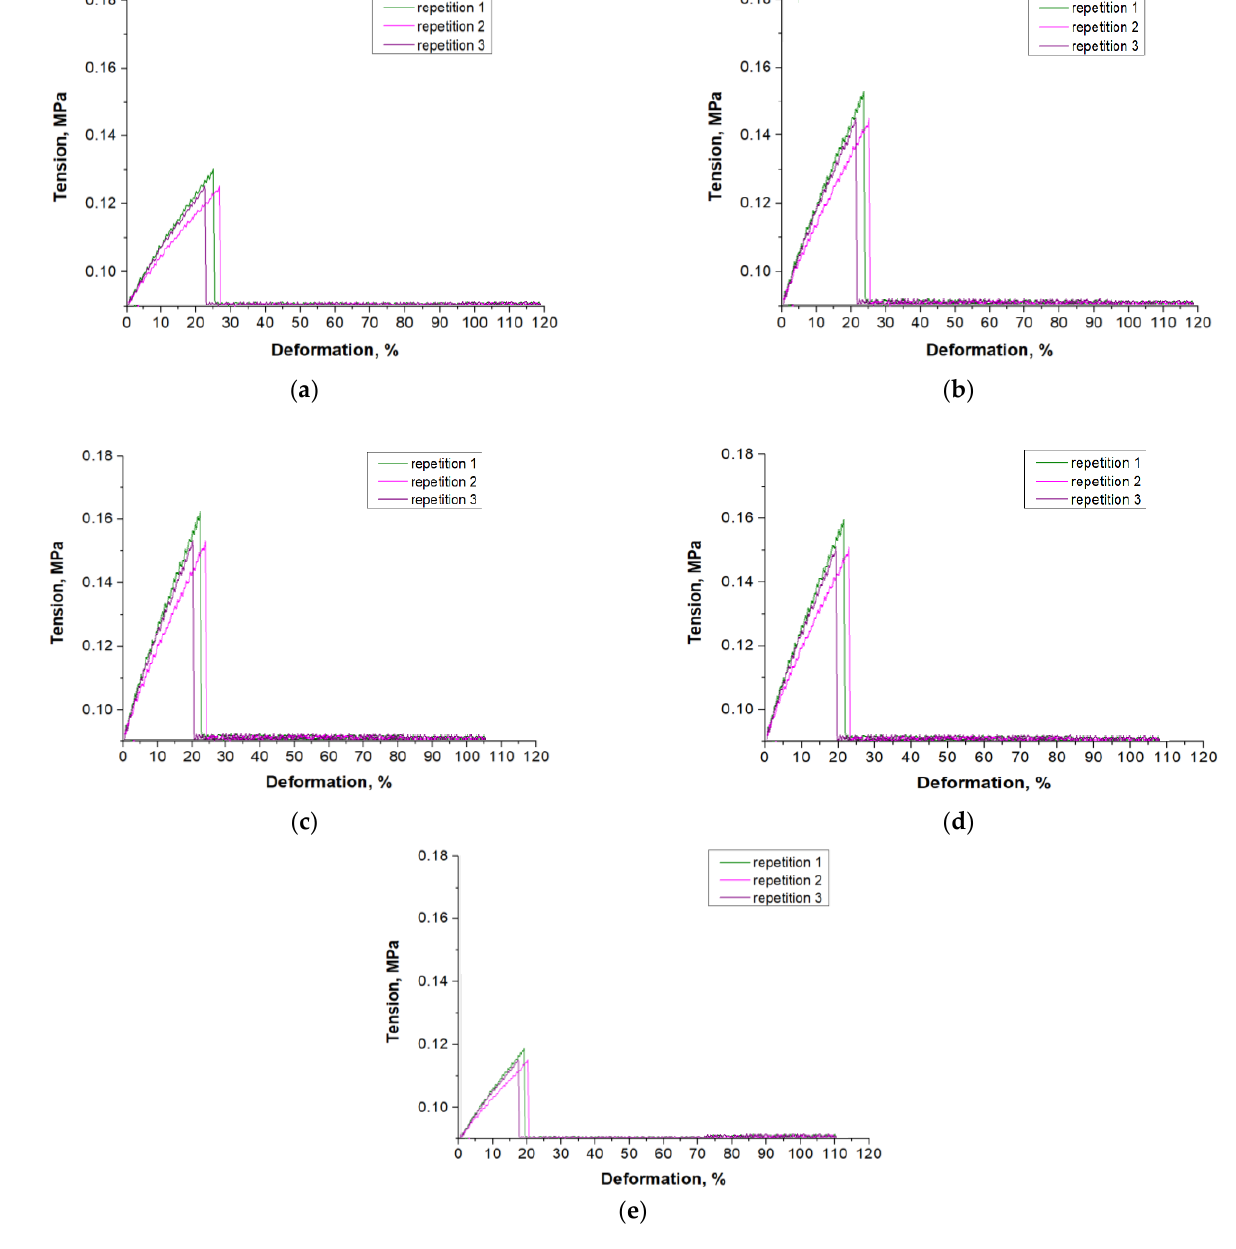
Figure 10. The stress-strain curves of hydrogel samples: 0.025/Photo ( a ), 0.075/Photo ( b ), 0.100/Photo ( c ), 0.125/Photo ( d ) and 0.150/Photo ( e ).